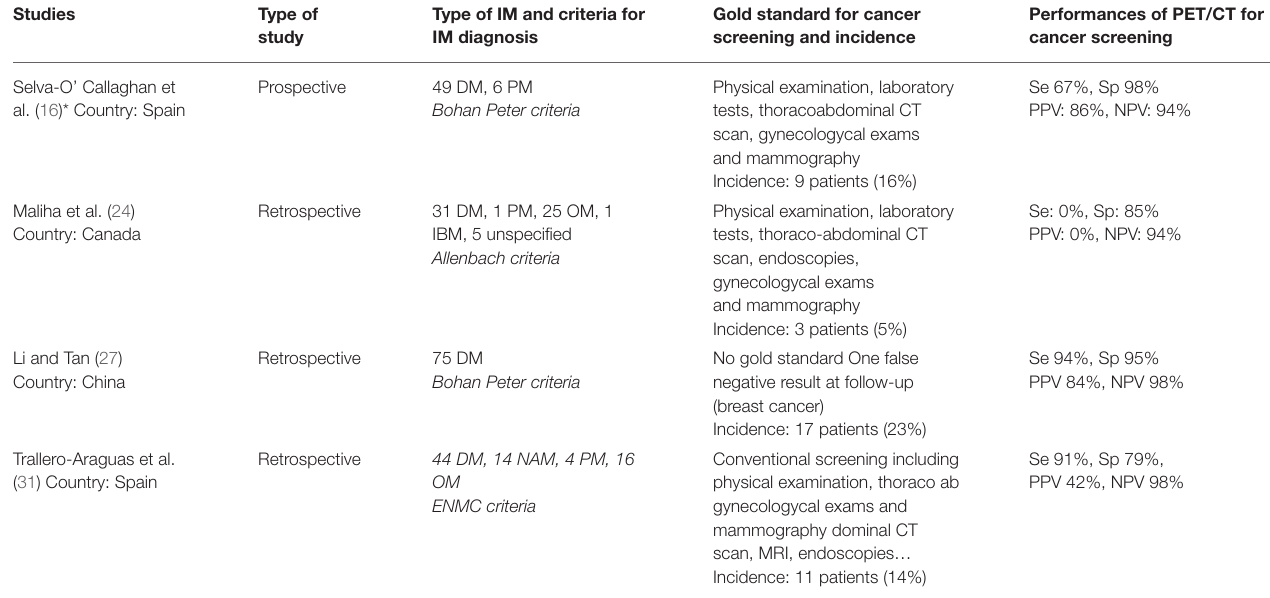
TABLE 2 | Studies evaluating the performance of [ 18 F]FDG-PET/CT for cancer diagnosis in inflammatory myopathies.